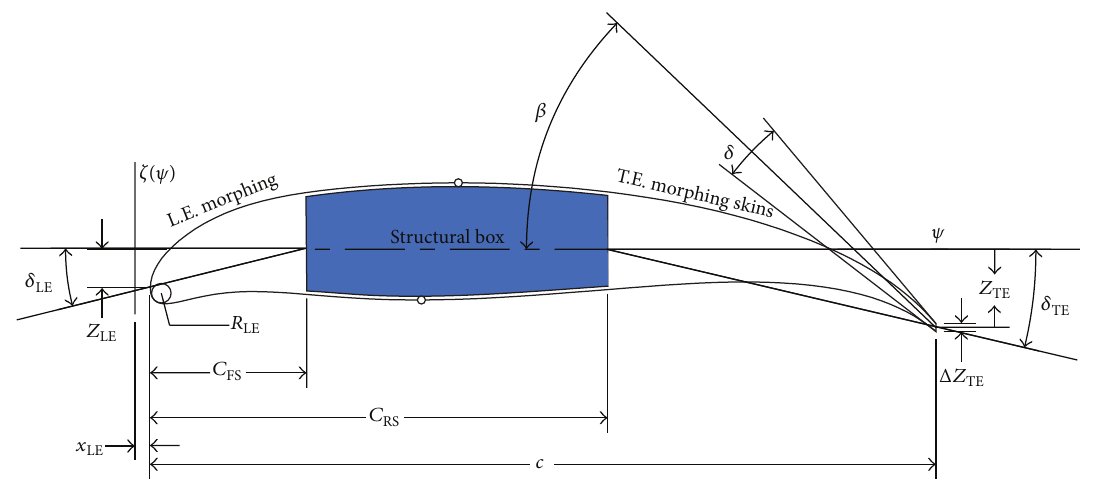
Figure 3: CSTv3 geometric parameters for airfoil